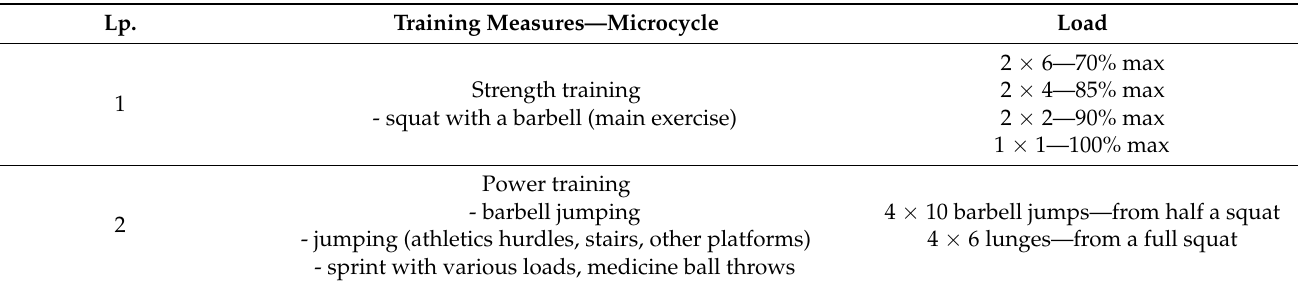
Table 2. Examples of training measures (strength and power training) used in the microcycle of preparation of a short-track